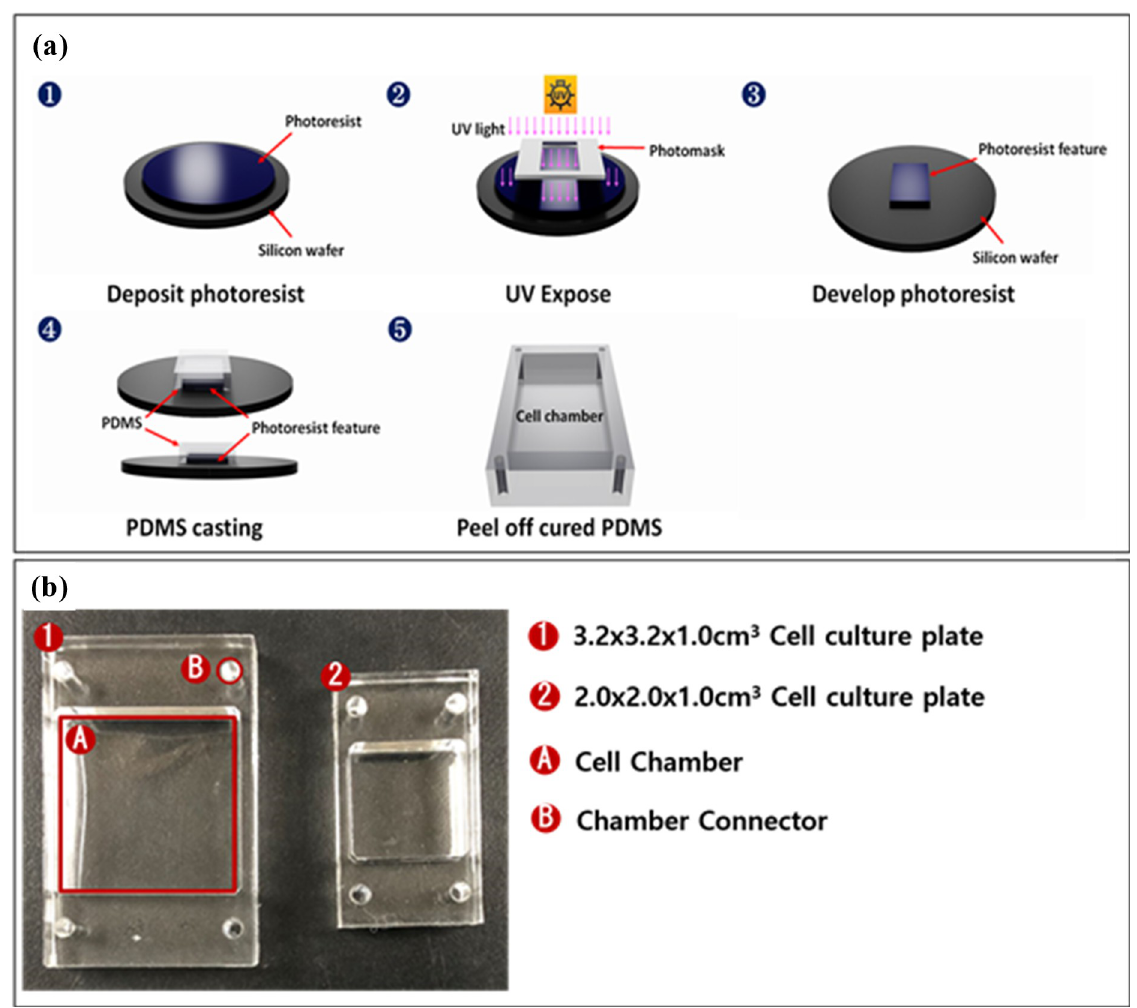
Fig 2. Flexible polydimethylsiloxane chamber. (a) Photolithography process; (b) PDMS stretch chambers compatible with the